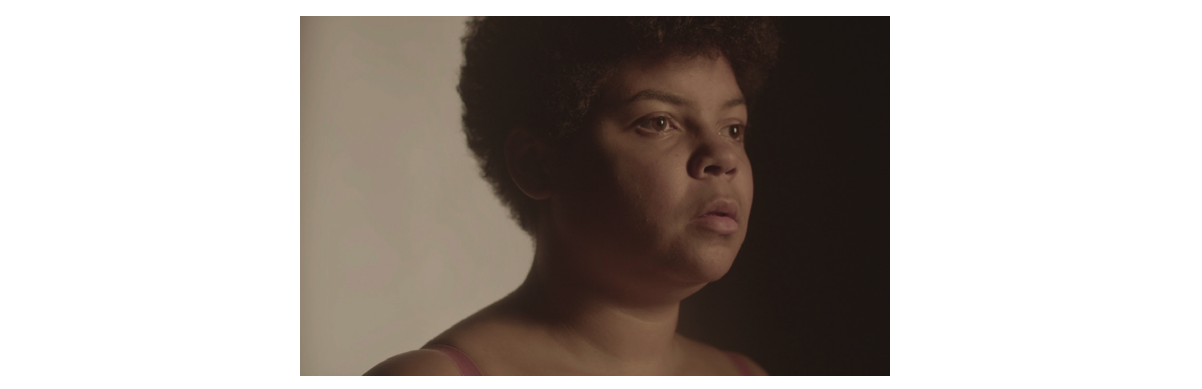
Figure 18. Close-up shot with anxious mood by Group 4 (Source: